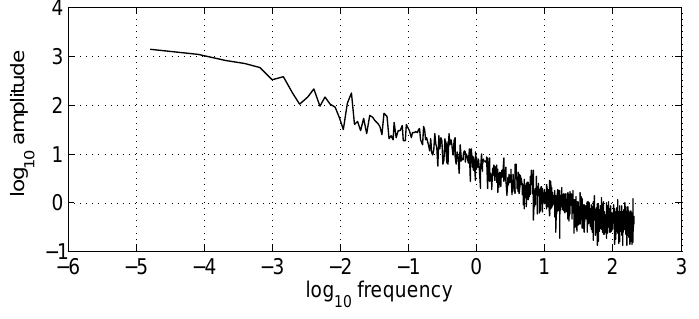
Figure 4. Power spectral density of the ∆ P signal measured in absence of movement and caused by the air flowing inside the duct because of wind.